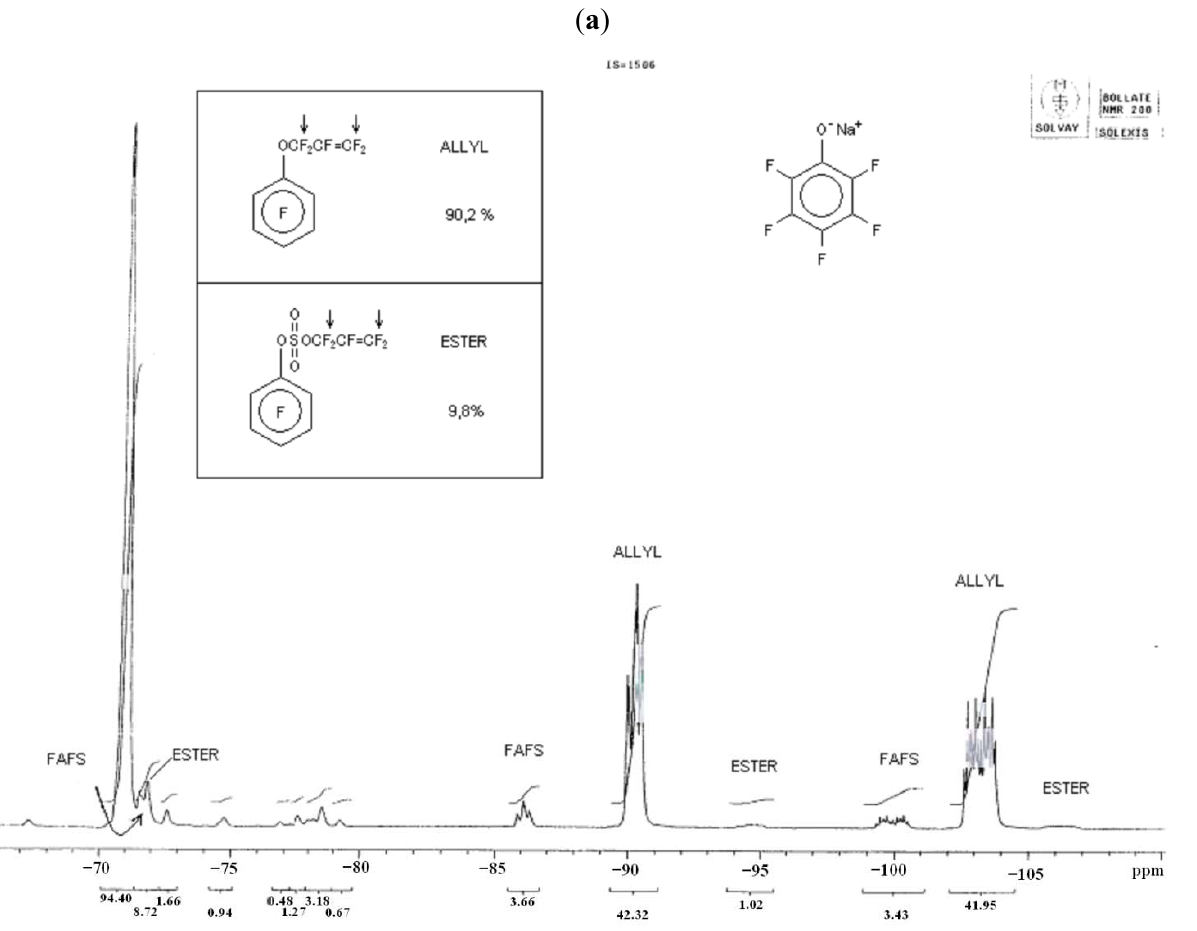
F ONa, ( b ) C F OK 6 5 6 5